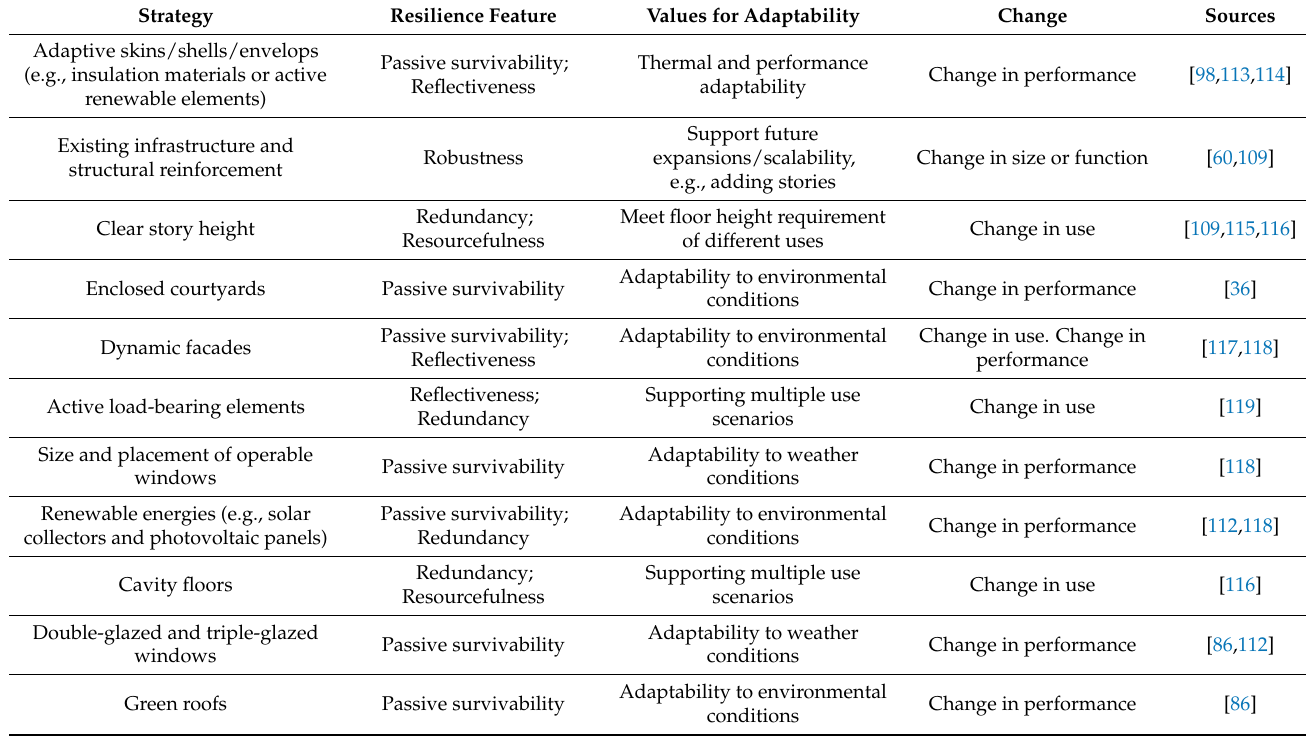
Table 6. Resilience strategies in buildings and their adaptability